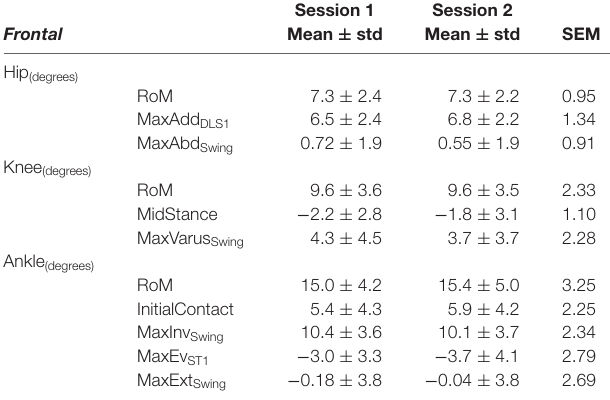
TABLE 7 | Frontal plane variables—Fastest Comfortable Walking Speed: mean ± standard deviation (std) for Session 1 and Session 2, and Standard Error of Measurement (SEM).